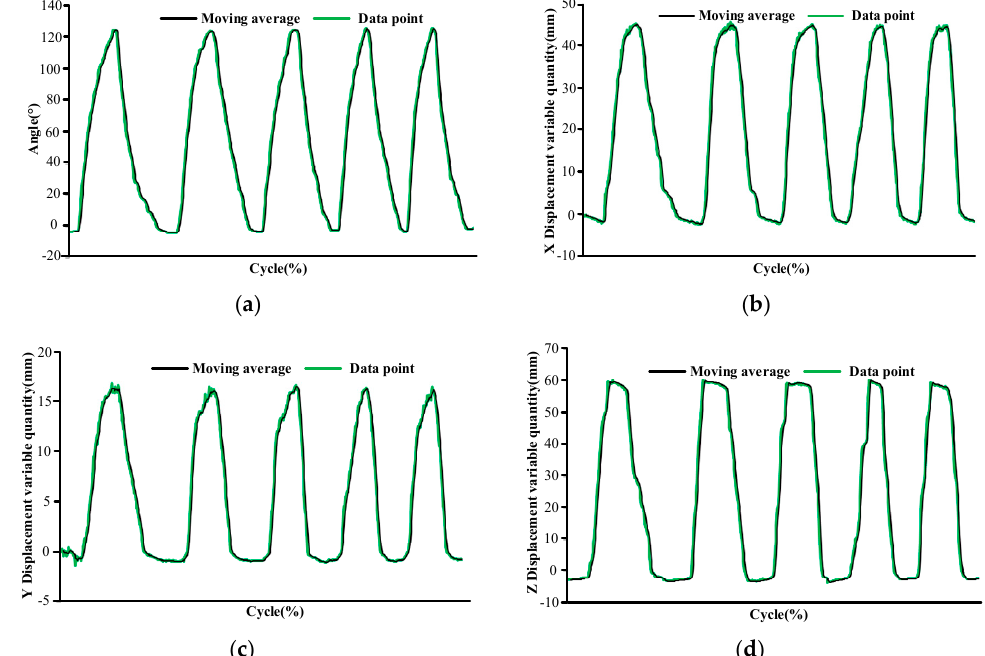
Figure 7. Diagrams of the GH joint motion information relative to the thorax coordinate system during humeral raising and lowering movements five cycles in the coronal plane: ( a ) humeral raising and lowering angle, ( b ) X-direction of the GH joint displacement variable quantity, ( c ) Y-direction of the GH joint displacement variable quantity, and ( d ) Z-direction of the GH joint center displacement variable quantity.